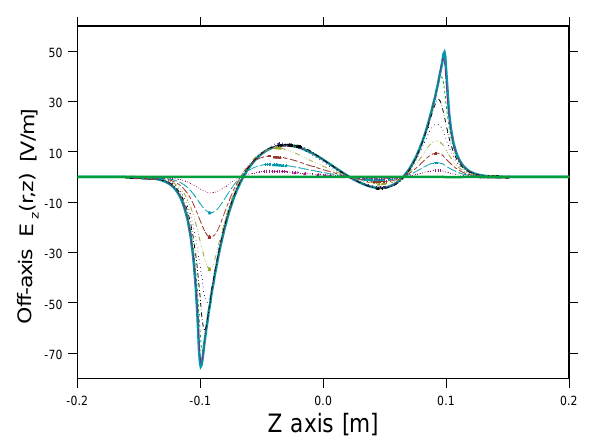
FIG. 5. (Color) Off-axis electric field E z (cid:1) r , z (cid:2) as a function of z for different radii: 0 # r # 2 cm for the beam bunch of Fig.